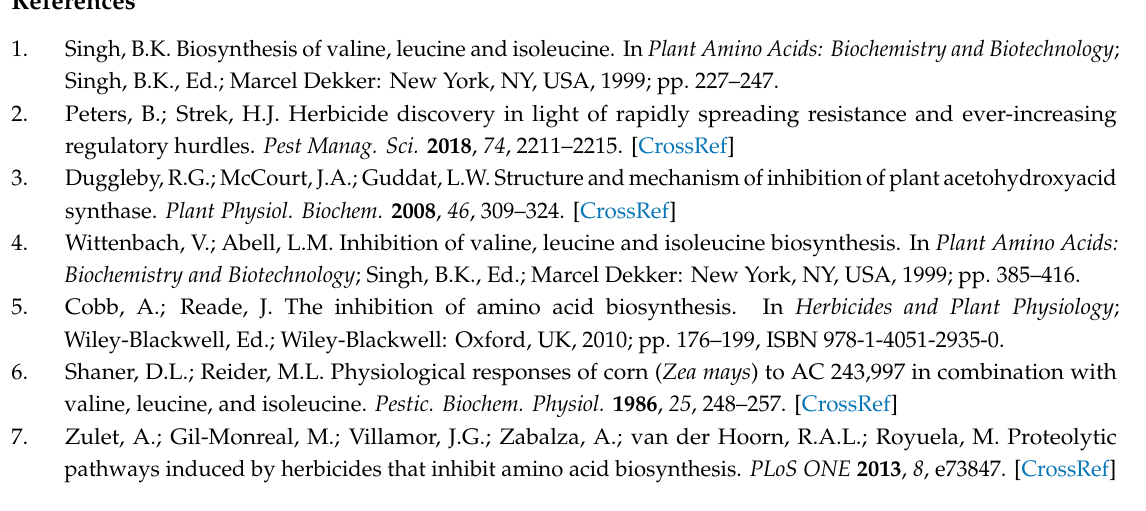
Figure S1: Original blots and band intensity of the Native PAGE for alcohol dehydrogenase, Figure S2: Original blots and band intensity of the immunoblot detection of pyruvate decarboxylase, Figure S3: Original blots and band intensity of the immunoblot detection of alcohol dehydrogenase, Table S1: Results of the two-way analysis of